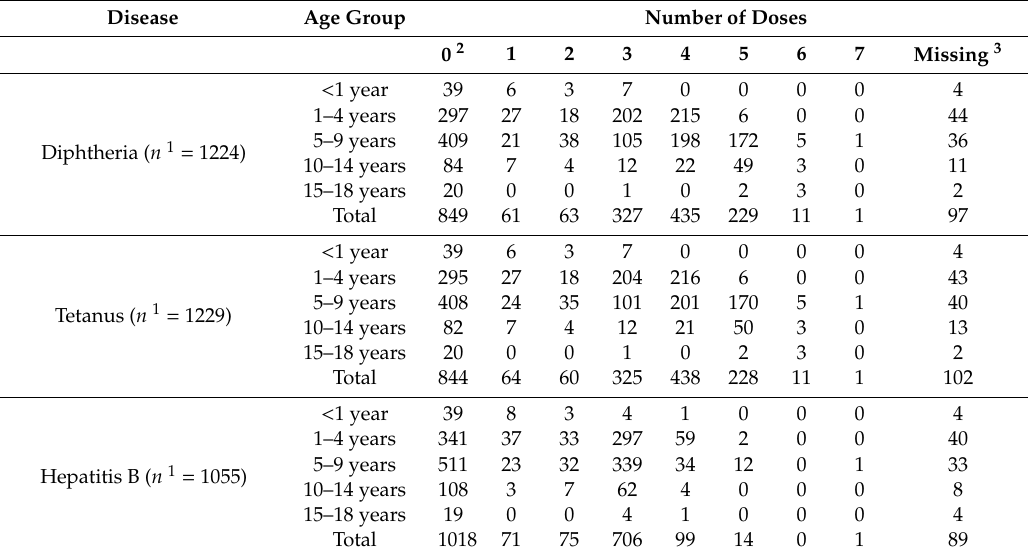
Table 6. The number of documented doses for IAC, by age